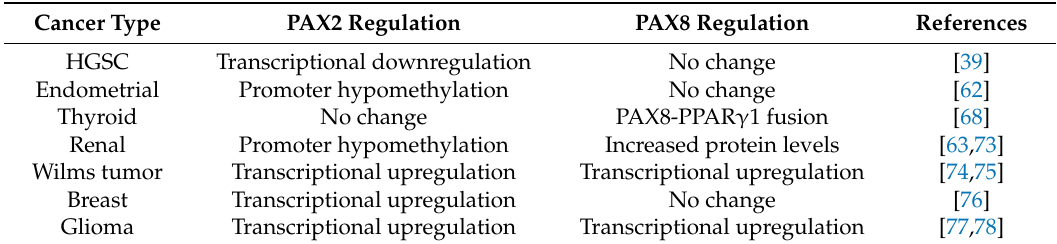
Table 1. Mechanism of PAX2 and PAX8 regulation in specific cancer